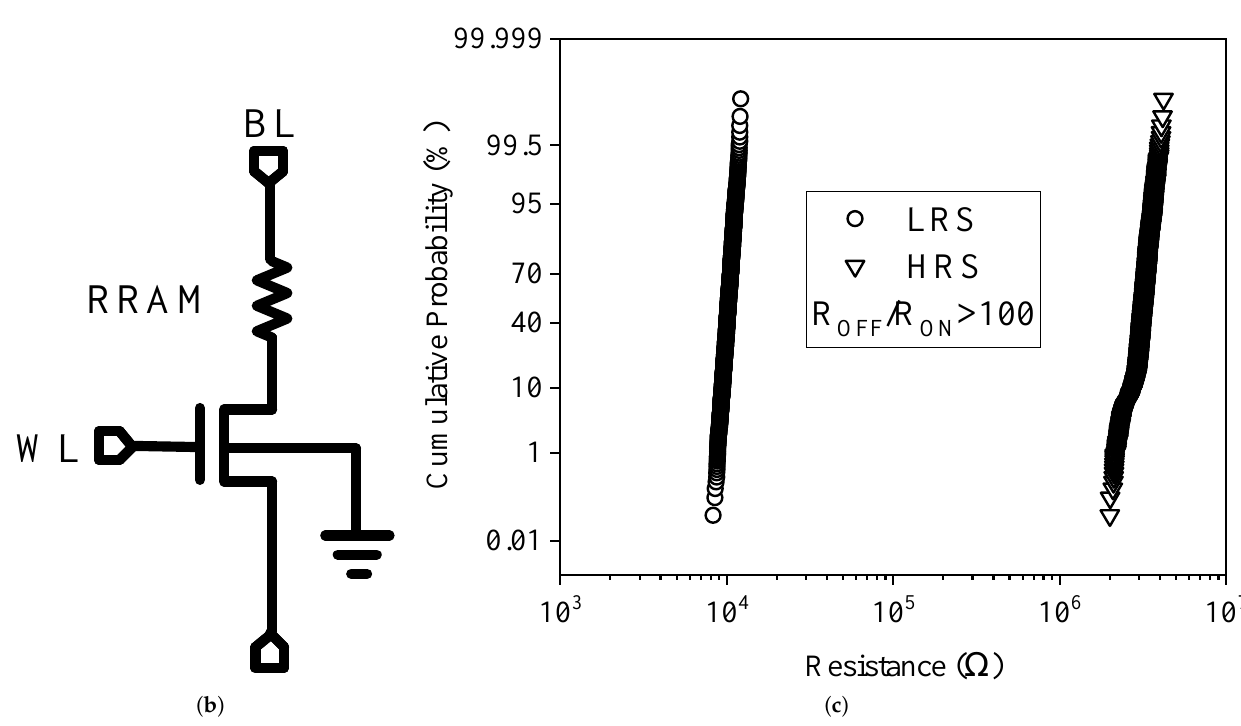
Figure 8. ( a ) The IV curves [35]. ( b ) Schematic of a single 1T1R structure. ( c ) The resistance distribution diagram of RRAM [35]. Table 4. Key parameters of the RRAM